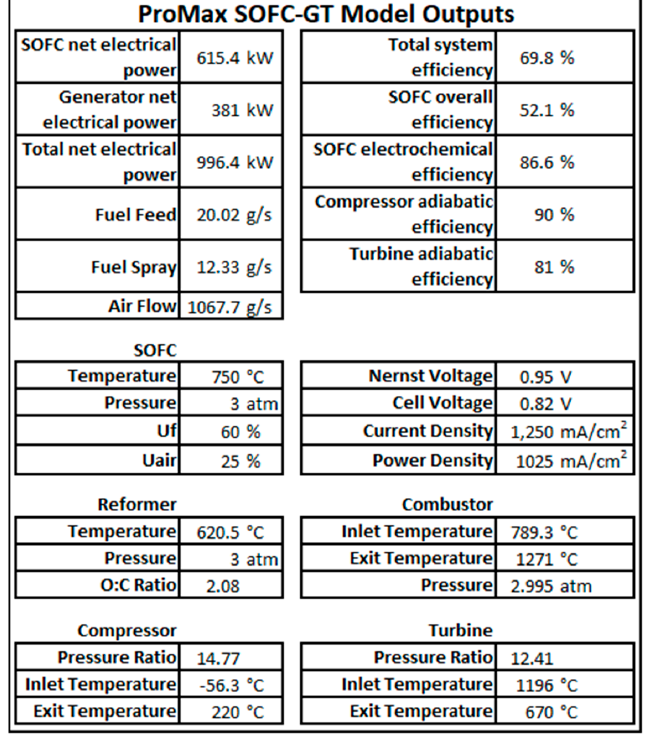
Figure 8. Our hybrid SOFC model for a 1-MW hybrid system operated at 36,000 ft (10,973 m) cruise altitude.